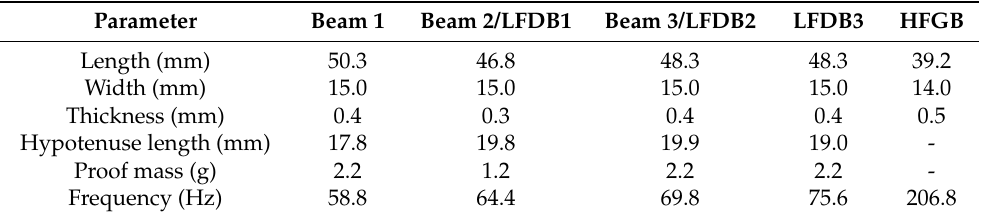
Table 1. The parameters of AB-VEH and novel VEH systems.